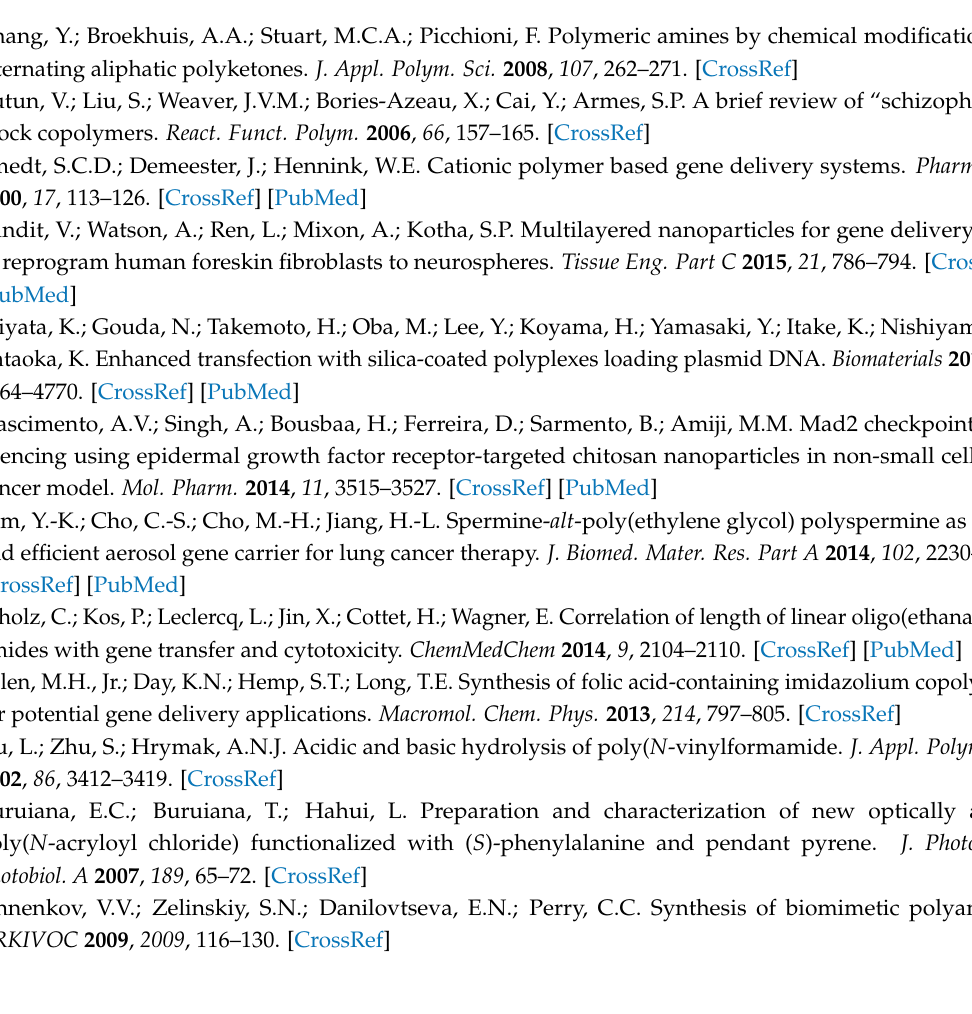
Figure S1: FTIR spectra of the new polymers; Figure S2: FTIR spectra of new polymers and siliceous composites; Figures S3–S5: Representative gel electrophoresis results for DNA oligonucleotide complex with new polymers; Figures S6 and S7: Representative gel electrophoresis results for DNA oligonucleotide complex with new polymers and